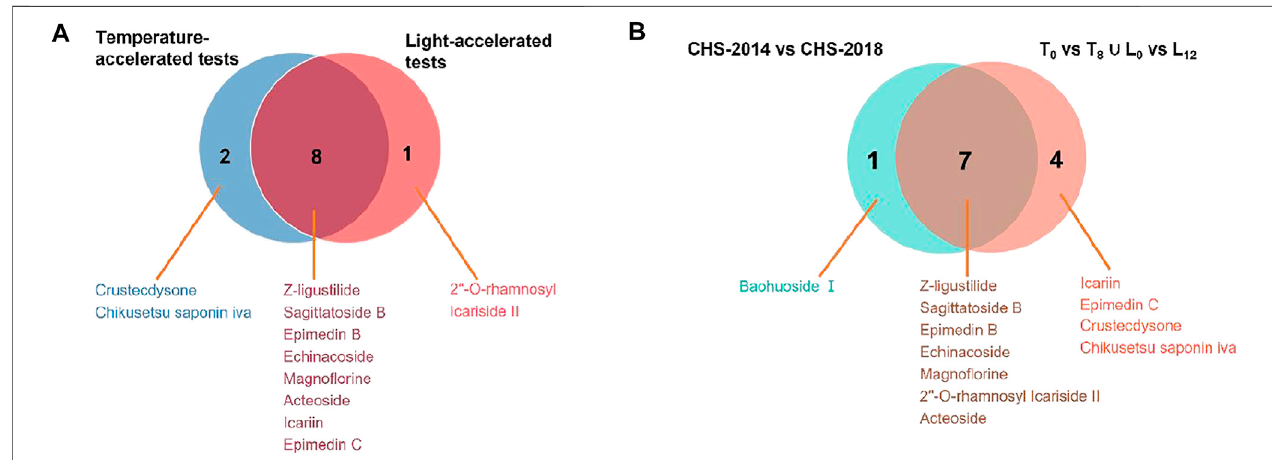
Frontiers in Pharmacology |